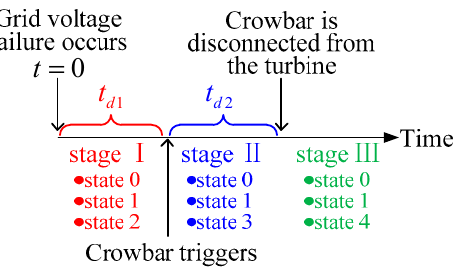
Figure 4. Timing diagram of crowbar response under grid fault.